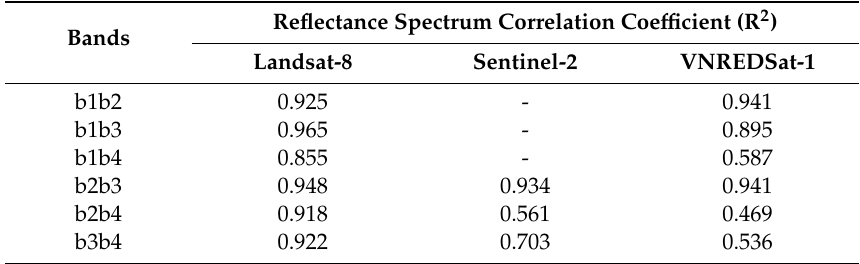
Table 5. Reflectance spectrum correlation coe ffi cients for each band pair. Reflectance Spectrum Correlation Coe ffi cient (R 2 Bands